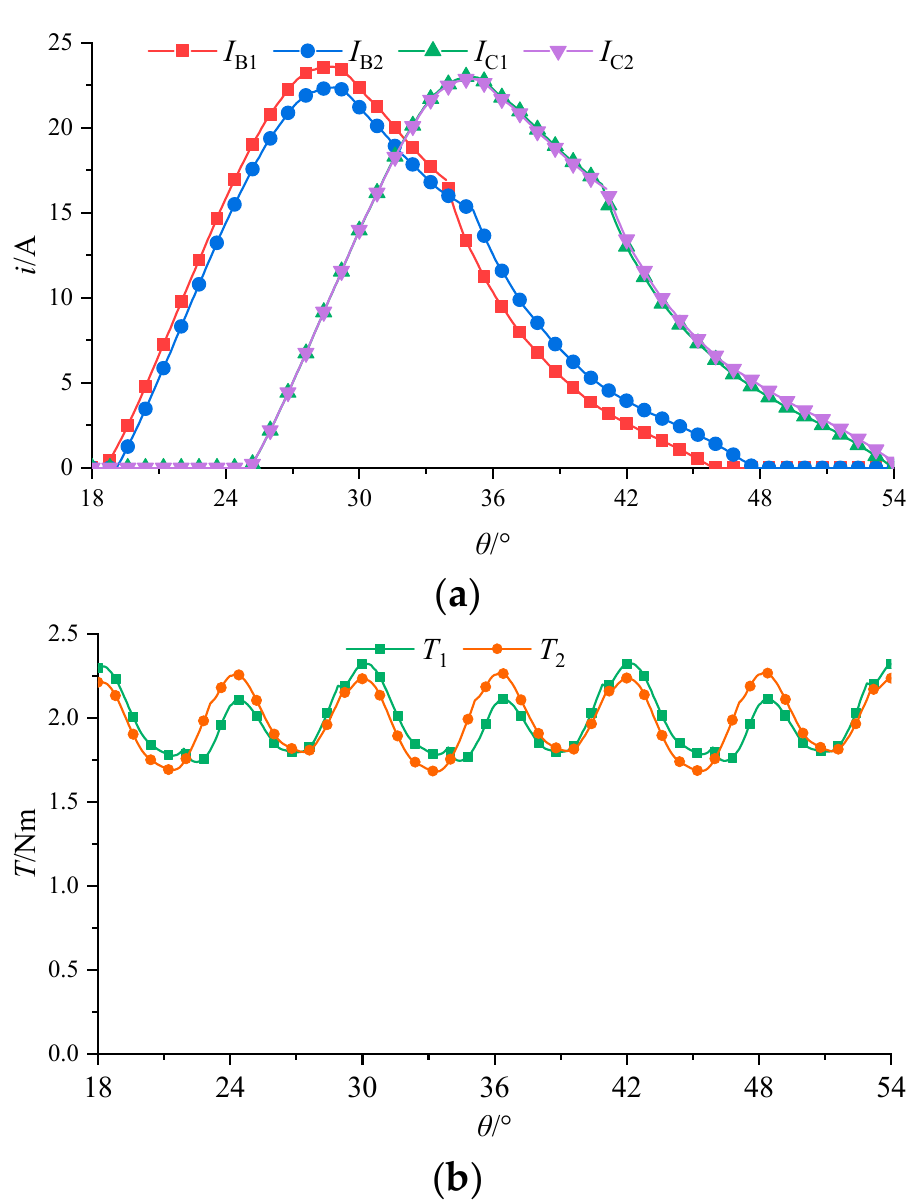
the SRM is defined as 1000 r/min due to the accuracy of the torque and speed sensor. Figure 9b,c present the torque and phase currents based on symmetrical control and asymmetric control, respectively. Channels 1, 2, and 3 are output torque and currents of phases B and C, respectively. As presented in Figure 9b,c, the peak value of torque for symmetrical control and asymmetric control are similar, and the valley value of torque can be enhanced through asymmetric control. Moreover, the phase current is more symmetrical for asymmetric control.